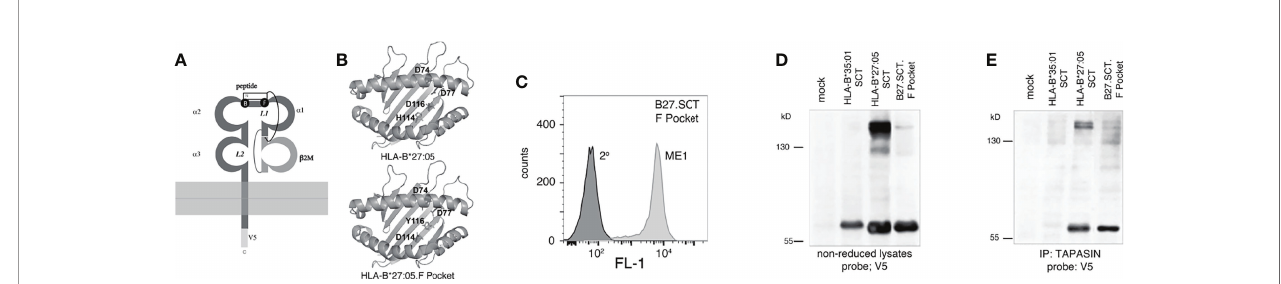
FIGURE 5 | F pocket residue substitutions of H114D and D116Y alter the ability of the HLA-B27.SCT to dimerise within the PLC. (A) Diagram illustrating the B and F pockets within the HLA-B27 SCT. (B) Ribbon structure of HLA-B27 antigen binding groove generated from pdb fi le 5ib2 for HLA-B*27:05 illustrating the following residues (stick) H114 and D116 and additional D74 and D77 residues contributing to the overall charge of the F pocket (top panel). Similar structure illustrating D114 and Y116 residues of the HLA-B27.F pocket SCT along with the aforementioned aspartic acid residues. (C) Flow cytometric analysis of HeLa cells expressing HLA- B27.F pocket SCT as detected by staining with the conformationally dependent ME1 antibody. (D, E) F pocket substitutions alter HLA-B27.SCT dimerisation as detected in whole cell lysates and peptide loading complex. (D) Immunoblotting of NEM treated cell lysates with the anti-V5 antibody revealed high molecular weight dimeric structures for HLA-B*27:05.SCT but were diminished in the HLA-B27.F pocket SCT and were absent in the HLA-B*35:01 SCT. (E) HeLa cells expressing the respective SCT constructs were NEM treated and followed by lysis in 1% digitonin. Each was immunoprecipitated with anti-tapasin antibody. Immunoprecipitates were resolved by non-reducing 8% SDS-PAGE and immunoblotted with anti-V5